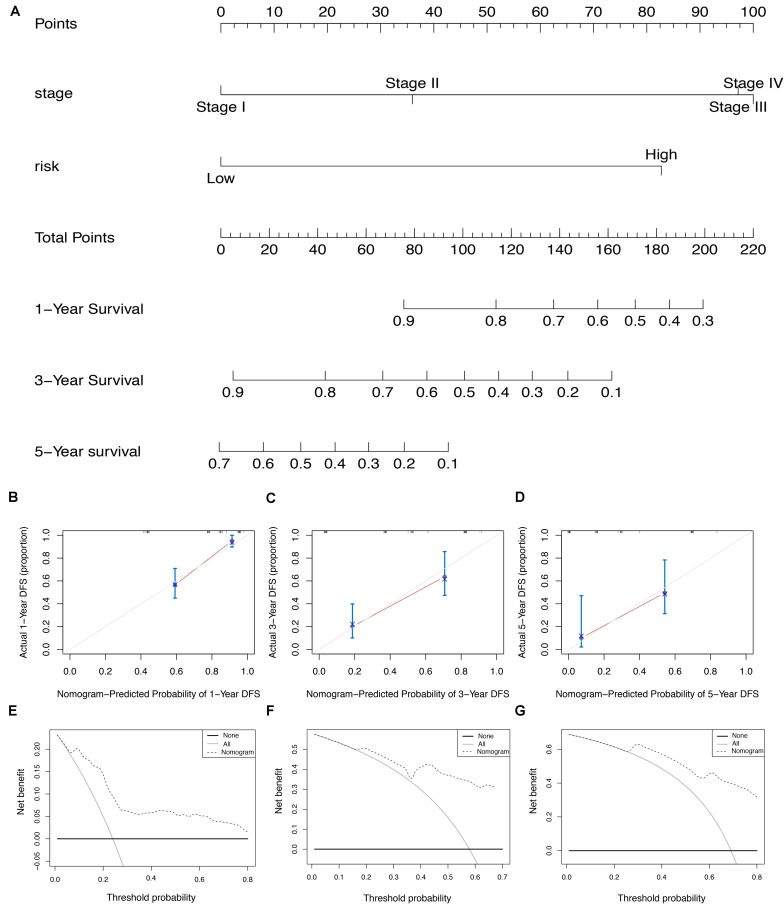
The AS-clinicopathologic nomogram for prediction on survival probability in patients with ESCA. (A) Development of AS-clinicopathologic nomogram for predicting 1-, 3-, and 5-years OS for ESCA patients. (B–D) Calibration plot of the AS-clinicopathologic nomogram in terms of agreement between nomogram-predicted and observed 1-, 3-, and 5-years outcomes in the ESCA cohort. The actual performances of our model are shown in red lines. And the silver line of 45° represents the ideal performance. (E–G) Decision curve analyses of the AS-clinicopathologic nomogram for 1-, 3-, and 5-years risk in ESCA cohort. The gray line represents the net benefit of treat-all scheme varying with threshold probability, while the black line represents the net benefit of treat-no scheme. The net benefits by using our nomogram for predicting 1-, 3-, and 5-years OS are displayed with imaginary line.